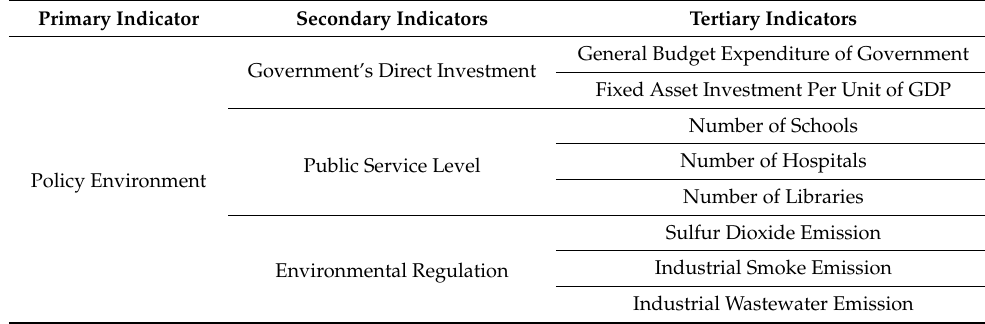
Table 1. Construction of policy environment